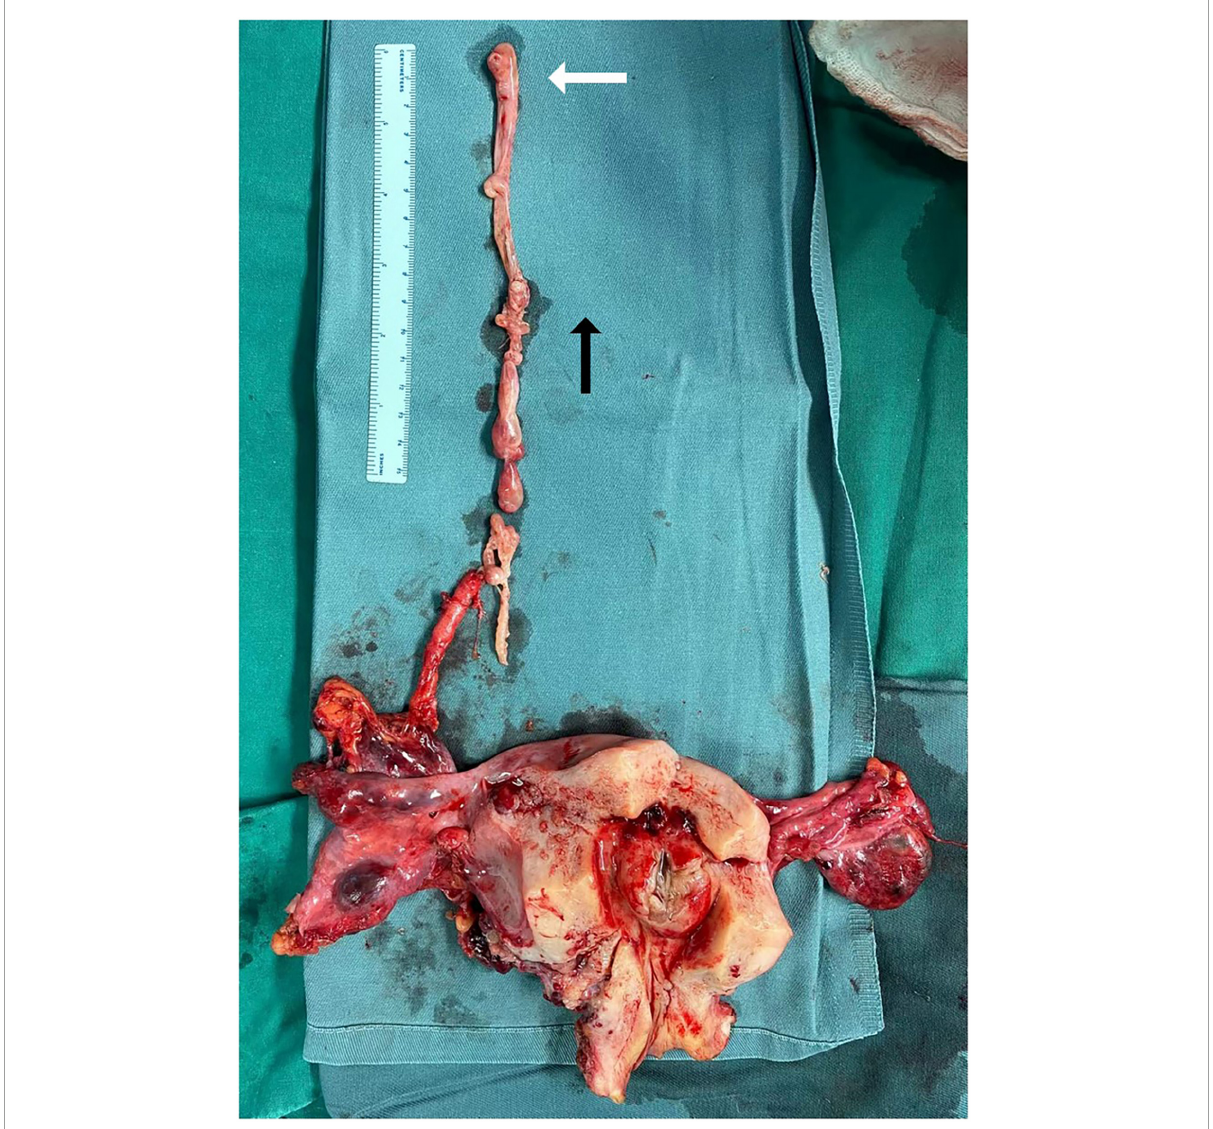
FIGURE4 Pathological specimens of intracardiac leiomyomatosis (ICL). The white arrow points to a tumor in the right atrium. Black arrow points to the side of the